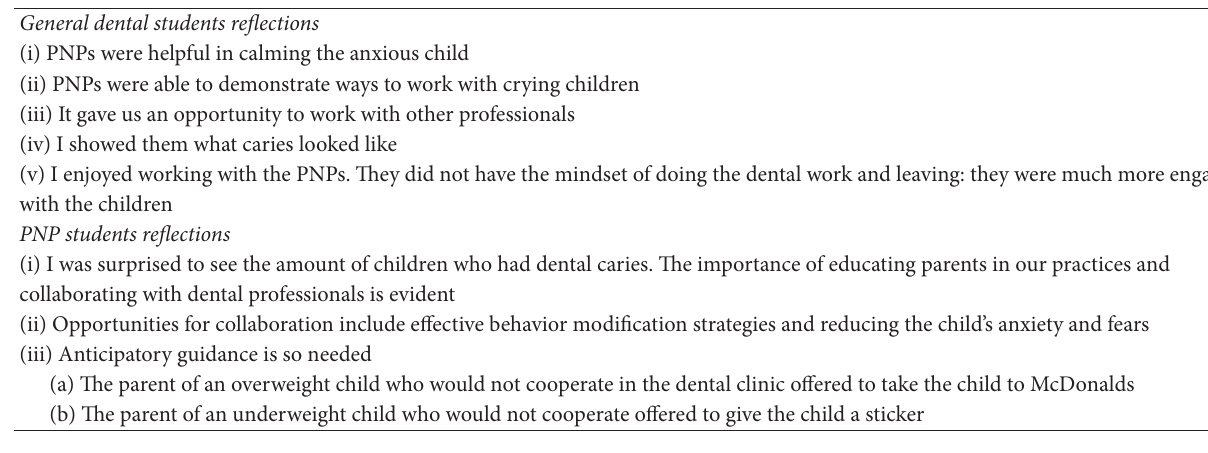
Table 1: Student reflections on interprofessional experiences.